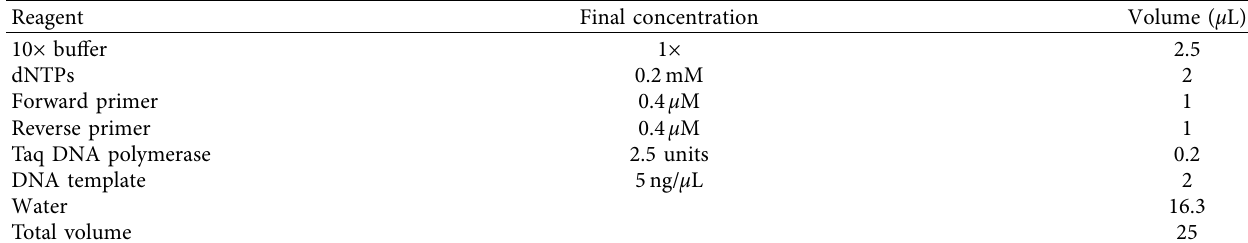
Table 2: PCR amplification